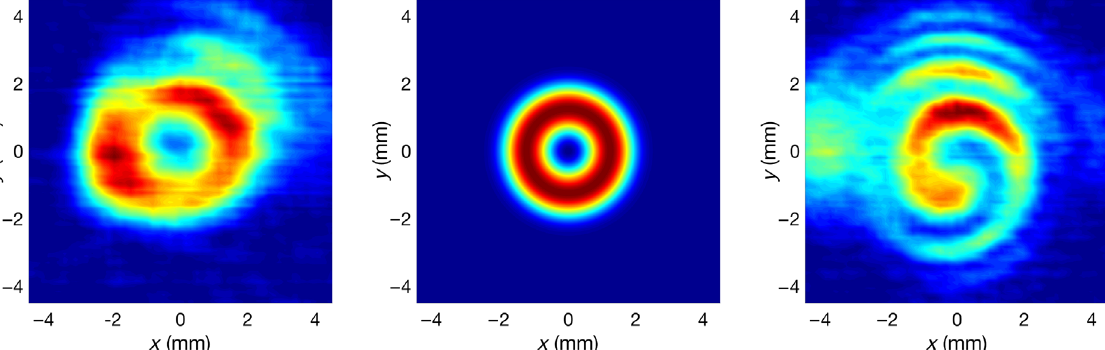
FIG. 4. Left panel: A typical single-shot image of the donut-shaped intensity pattern obtained by increasing the e-beam size. Middle panel: Calculation. Right panel: A single-spiral pattern obtained by interference of the optical vortex with a Gaussian mode (in a single- shot measurement), confirming the l ¼ 1 charge of the vortex